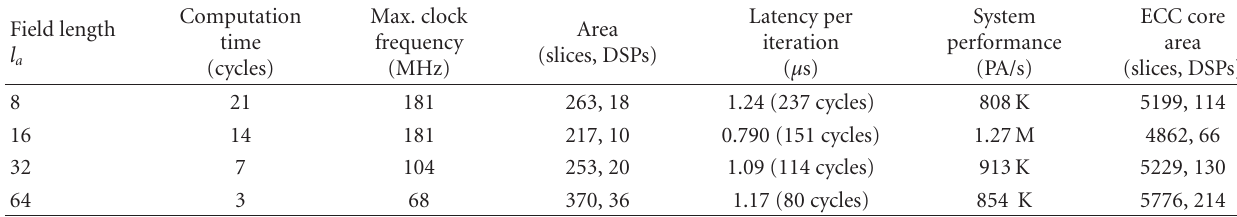
Table 2: Modular multiplier performance.